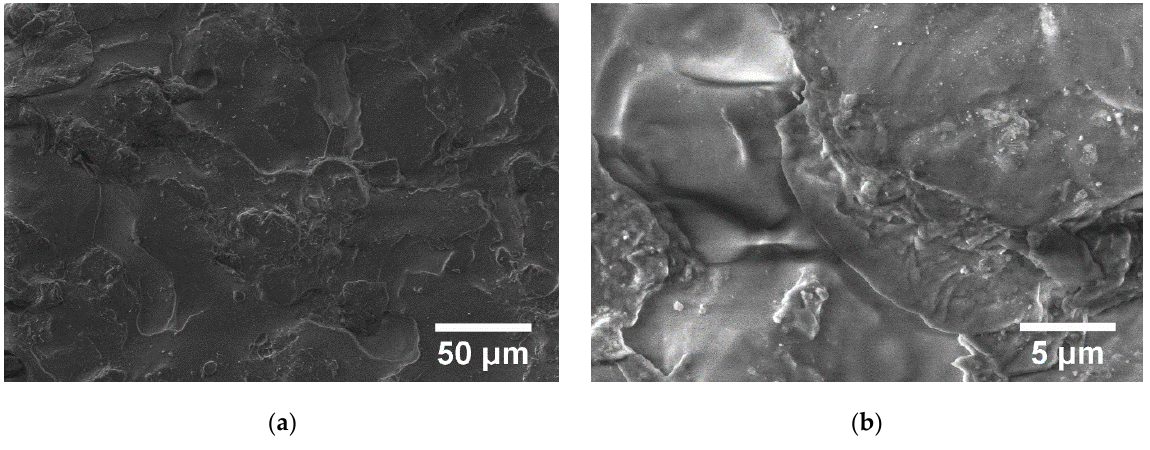
Figure 13. SEM images for PP at magnifications 1.000× ( a ) and 10.000× ( b ).